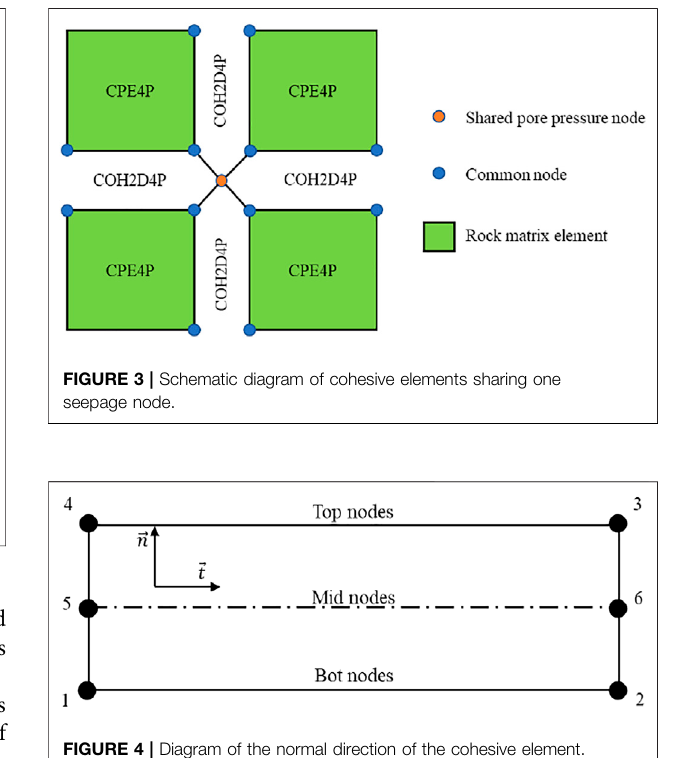
FIGURE 4 | Diagram of the normal direction of the cohesive